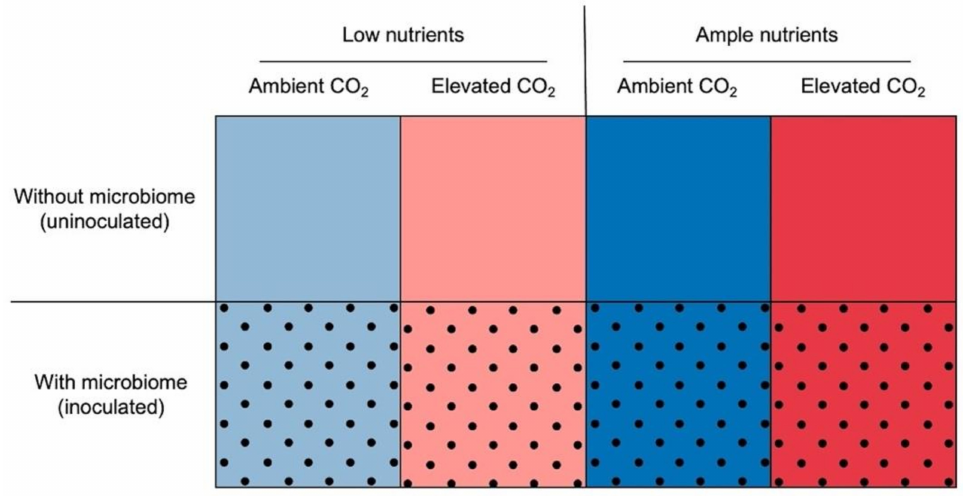
Figure 1. Schematic of the multi-factorial experimental design. Lighter and darker colors represent low and ample nutrient treatments, respectively. Ambient CO 2 conditions are blue and elevated CO 2 conditions are red. The dotted fill pattern represents inoculated